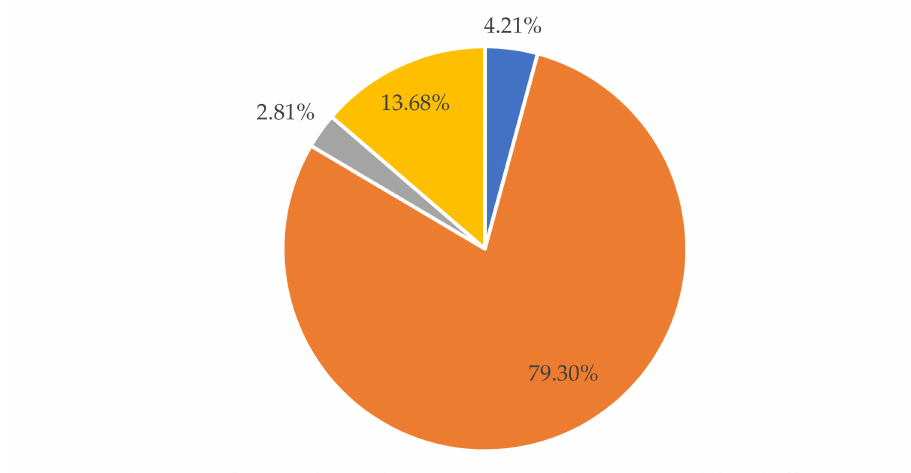
Figure 4. Articles by